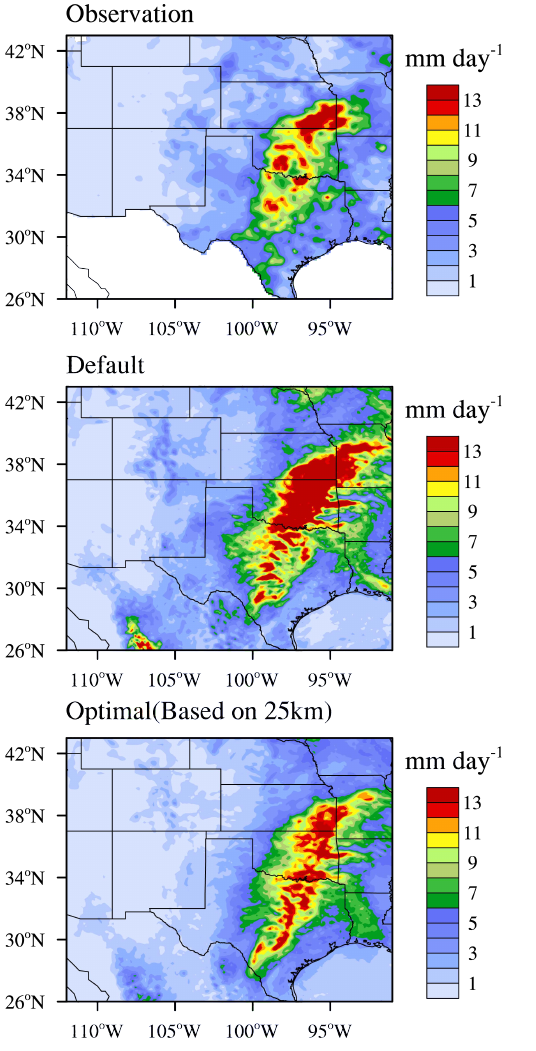
Fig. 13. The spatial distributions of observed and simulated (25-km) monthly mean precipitation with default and optimal parameters ob- tained at the SGP, respectively, over the North America Monsoon (NAM) region for July of